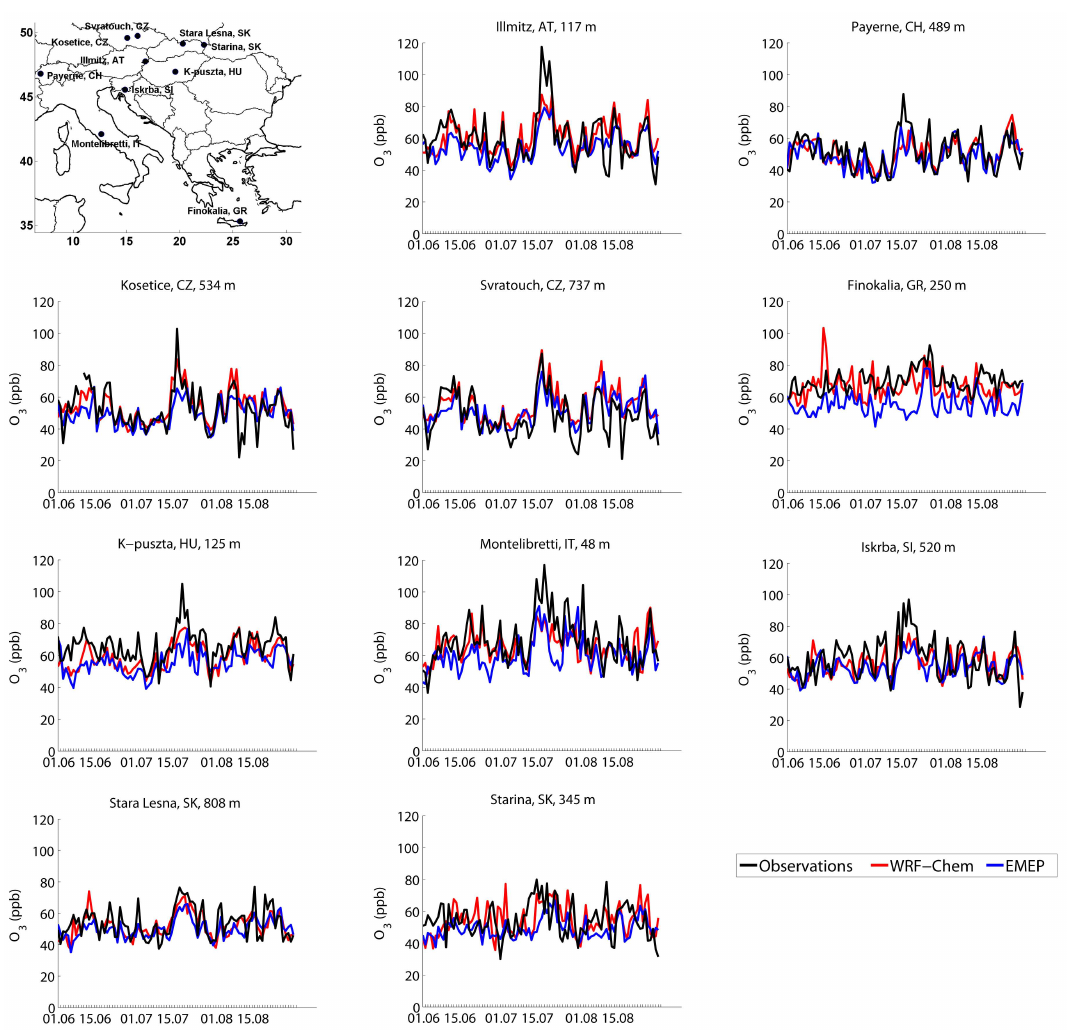
Fig. 8. Time evolution of daily maximum surface O 3 (ppbv) as measured and modelled by WRF-Chem and EMEP MSC-W for 10 stations during the summer 2007. The top left plot marks the location of each station included in the